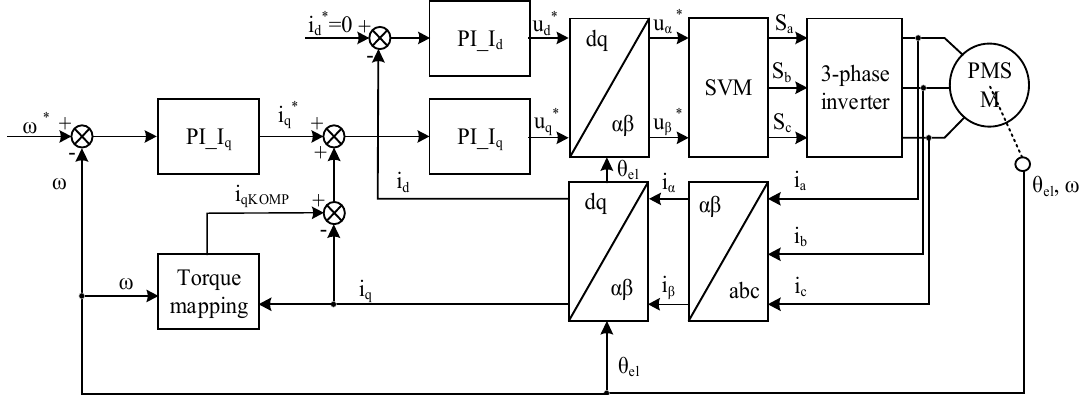
Figure 5. Block scheme of PMSM motor under FOC with oscillating torque compensation.